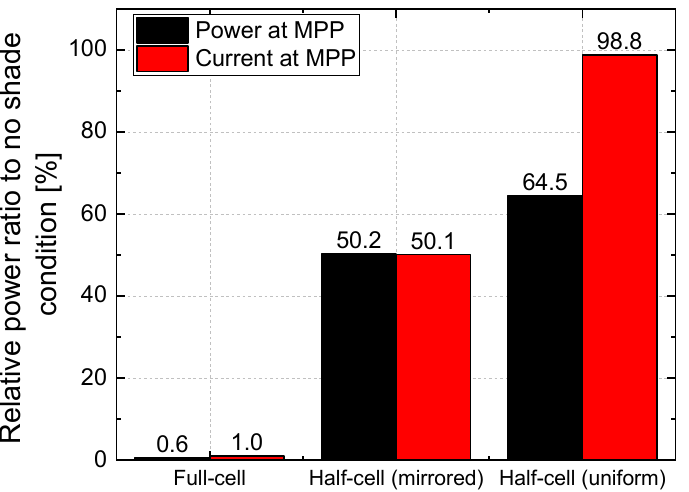
Figure 15. Comparison of measured power and current ratios of the the full cell, half cell (mirrored) and half cell (uniform) when the bottom row of the modules were 100% shaded.